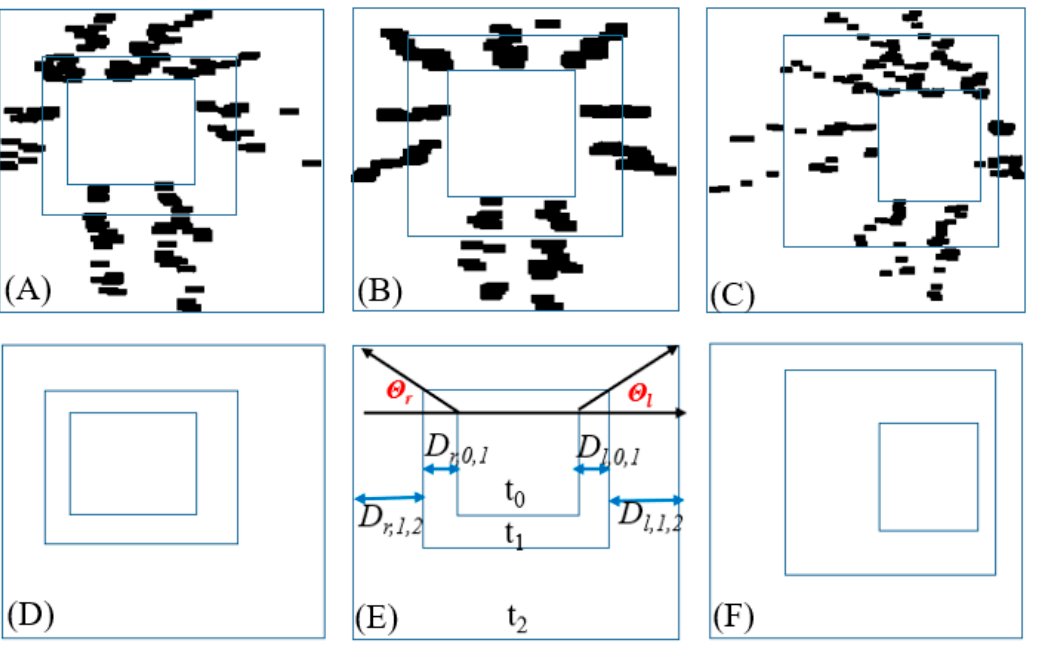
Figure 7. Graphical representation of the skewness or displacement for a walking video at three time points (i.e., t 0 , t 1 , t 2 ). ( A , D ), ( B , E ), and ( C , F ), respectively, present postural skew to the left, postural balance, and postural skew to the right with participants walking toward the camera.